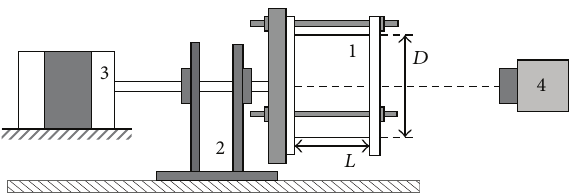
Figure 1: Sketch of experimental